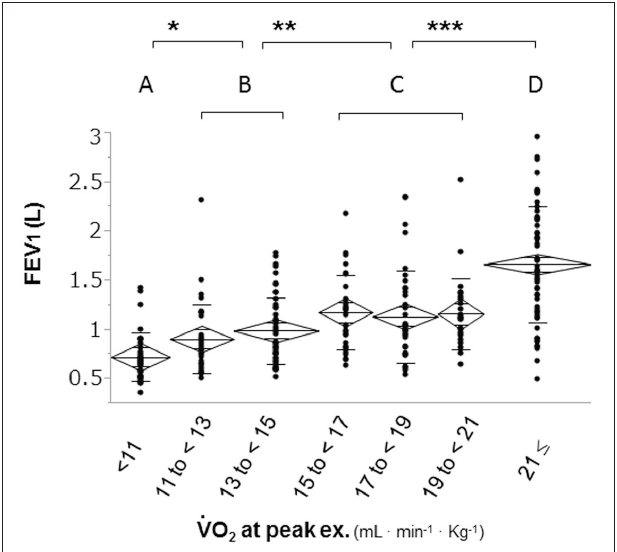
FIGURE 1 | Distribution of FEV 1 based on exercise tolerance. Patients were divided into seven groups according to increments of 2 mL · min − 1 · kg − 1 in peak ˙ V O2 to confirm the distribution of FEV 1 at different levels of exercise tolerance. The second subdivision of the patients was into four subgroups: group A ( < 11 ml · min − 1 · kg − 1 ); group B (11 to < 15 mL · min − 1 · kg − 1 ); group